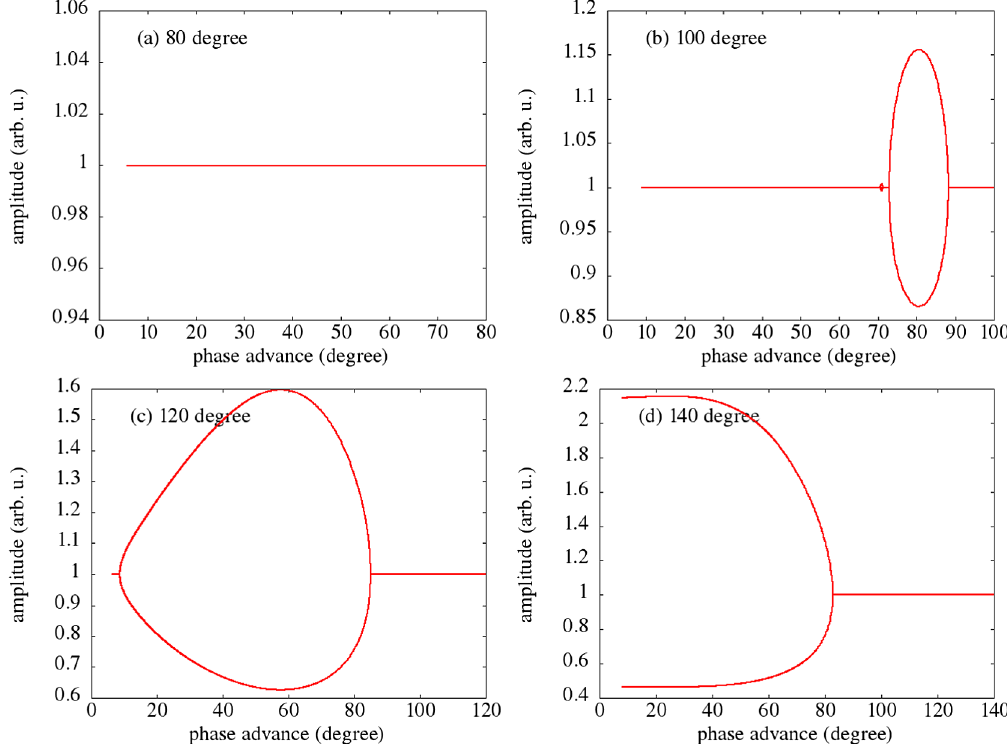
FIG. 10. The 2D envelope mode growth rate amplitudes as a function of depressed transverse phase advance for (a) 80 °, (b) 100 °, (c) 120 °, and (d) 140 ° zero current transverse phase advances in a periodic quadrupole